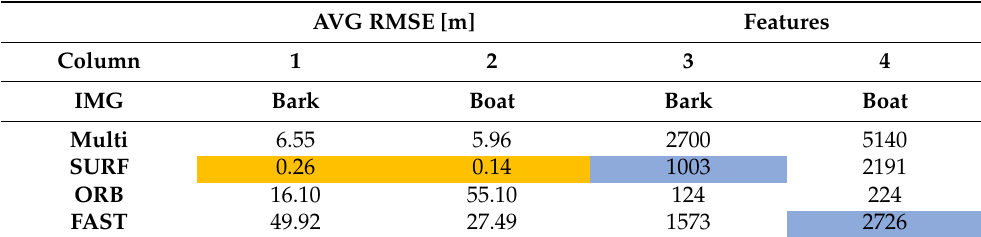
Table 2. Bark and boat average RMSE [m] and the average number of features detected.